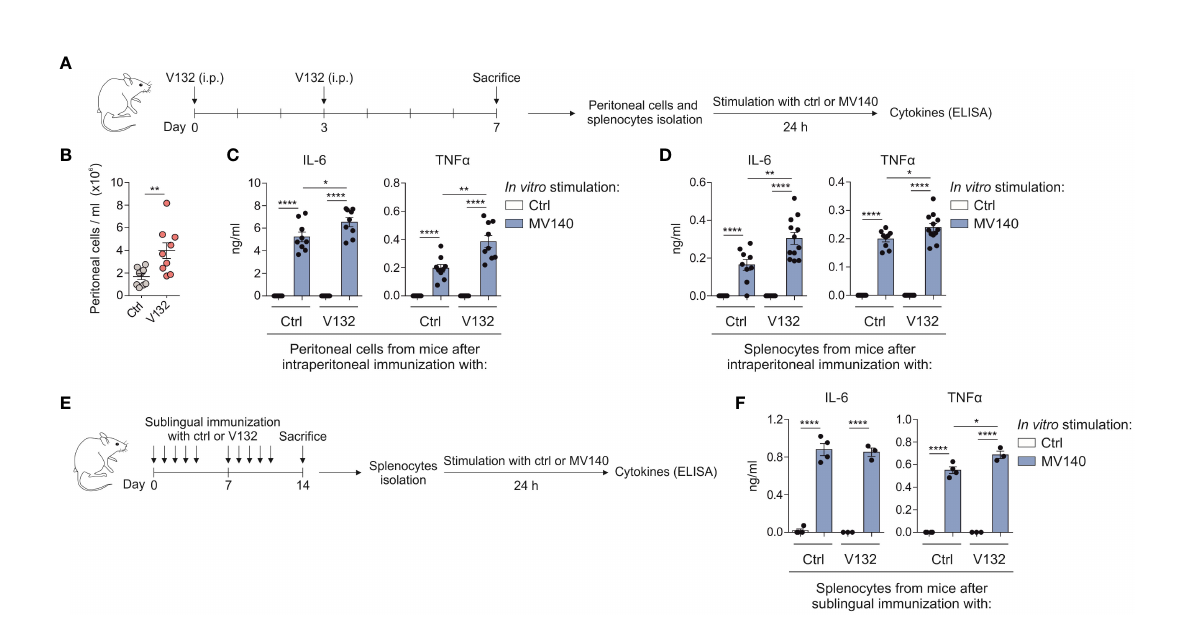
FIGURE 5 V132 induces trained immunity in mice and enhances innate immune responses after MV140 in vitro stimulation. (A) Scheme of the intraperitoneal immunization protocol and analysis of induced systemic response; i.p., intraperitoneal; ctrl; control excipients. (B) Concentration of peritoneal cells in the peritoneal cavity 4 days after last intraperitoneal immunization (n = 9 mice of two independent experiments). (C) Cytokine production by peritoneal cells from the indicated mice, stimulated in vitro with ctrl or MV140 for 24 h (n = 9 mice of two independent experiments). (D) Cytokine production by splenocytes from the indicated mice, stimulated in vitro with ctrl or MV140 for 24 h (n = 9-12 mice of two independent experiments). (E) Scheme of the sublingual immunization protocol and analysis of induced systemic response; ctrl; control excipients. (F) Cytokine production by splenocytes from the indicated mice, stimulated in vitro with ctrl or MV140 for 24 h (n = 3-4 mice of one independent experiment). Values are mean ± SEM. Statistical signi fi cance was determined using Unpaired t test. *P < 0.05, **P < 0.01, ****P <